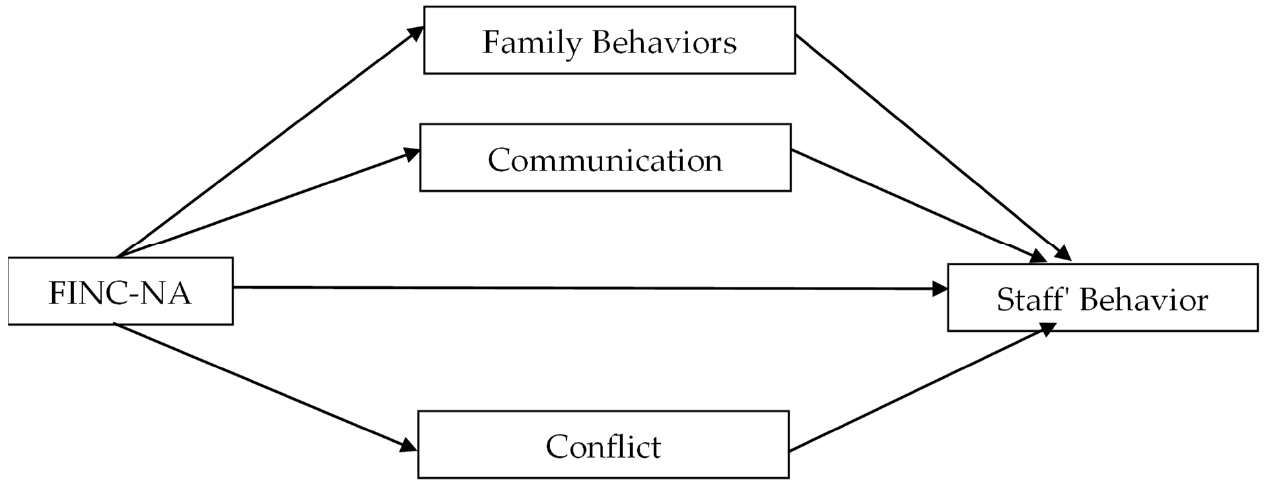
Figure 1. The research model. Abbreviation: FINC-NA, Families’ Importance in Nursing Care– Nurses’ Attitudes.